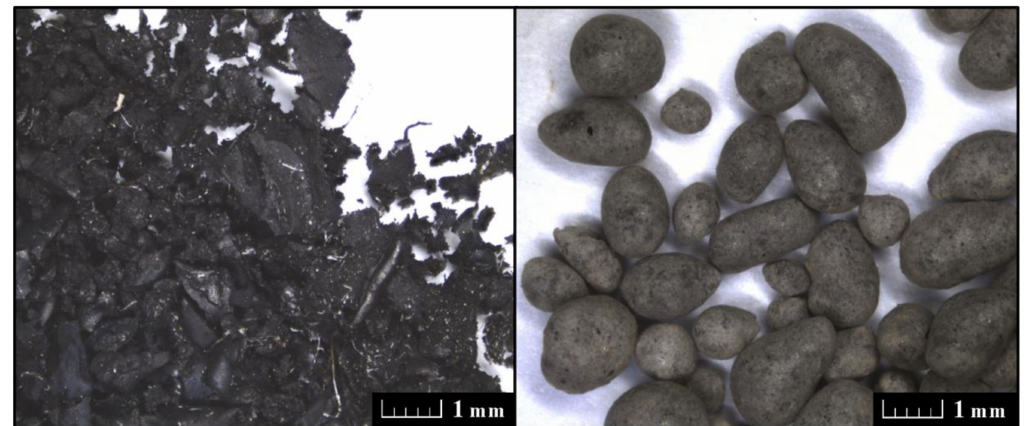
Figure 2. Rubber granulate ( left ) and expanded glass granulate ( right ), scale bar: 1